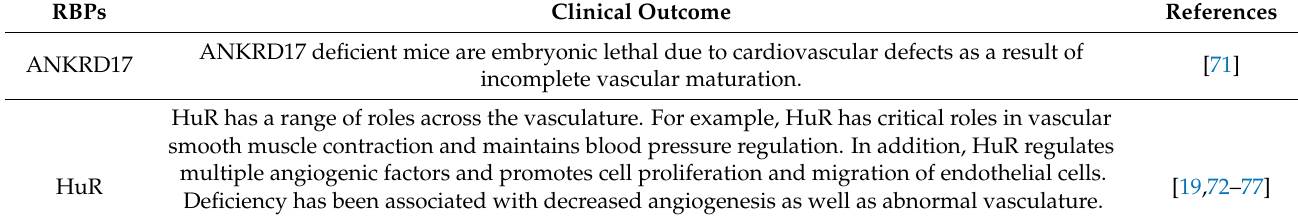
Table 1. Roles of RBPs within Vascular Health and Disease. RBPs Clinical